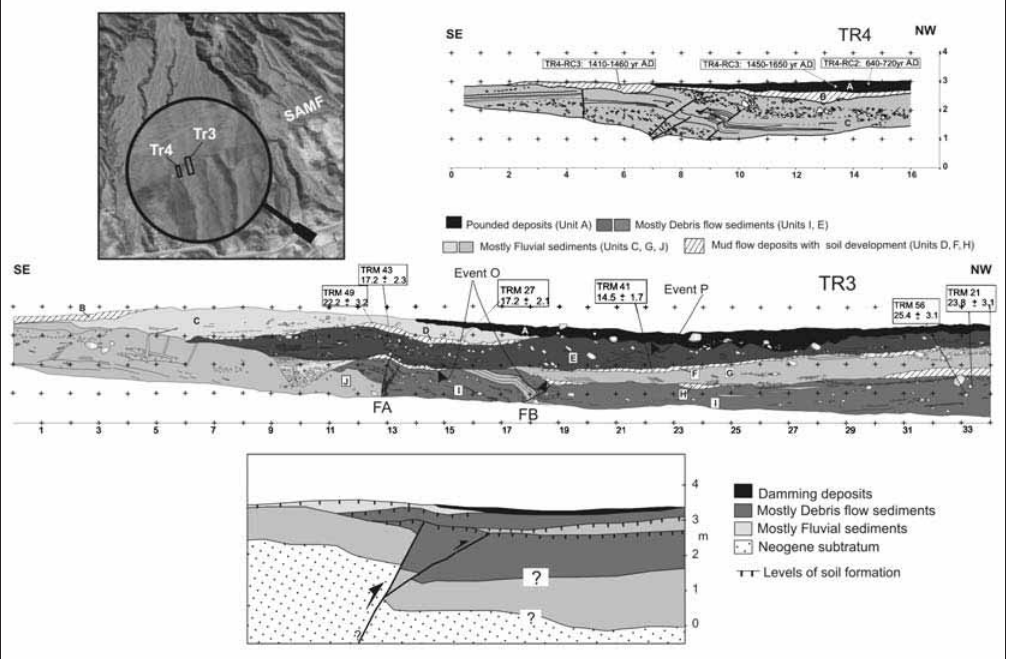
Fig. 5a,b. a) Aerial photograph showing the location of the two trenches dug across the SAMF. The logs of the trenches are interpreted. We differentiated 9 sedimentary units. The units D, E, F, G, H, I and J are clearly affect- ed by the movements of two strands of the SAMF (FA and FB). A is a pounded sedimentary unit that probably was deposited after the coseismic surface bending above the fault FA. At least two events (O and P) are recog- nized. Absolute ages obtained from thermoluminiscence and radiocarbon methods are labeled in the logs of the trenches (see tables II and III). b) Represents a tectono-sedimentary interpretation of the trenches, with 5 tec- tono-sedimentary units created by the paleoseismic activity of the